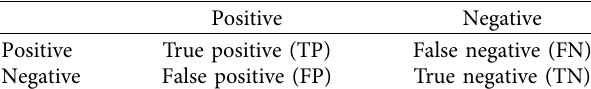
Table 2: The confusion